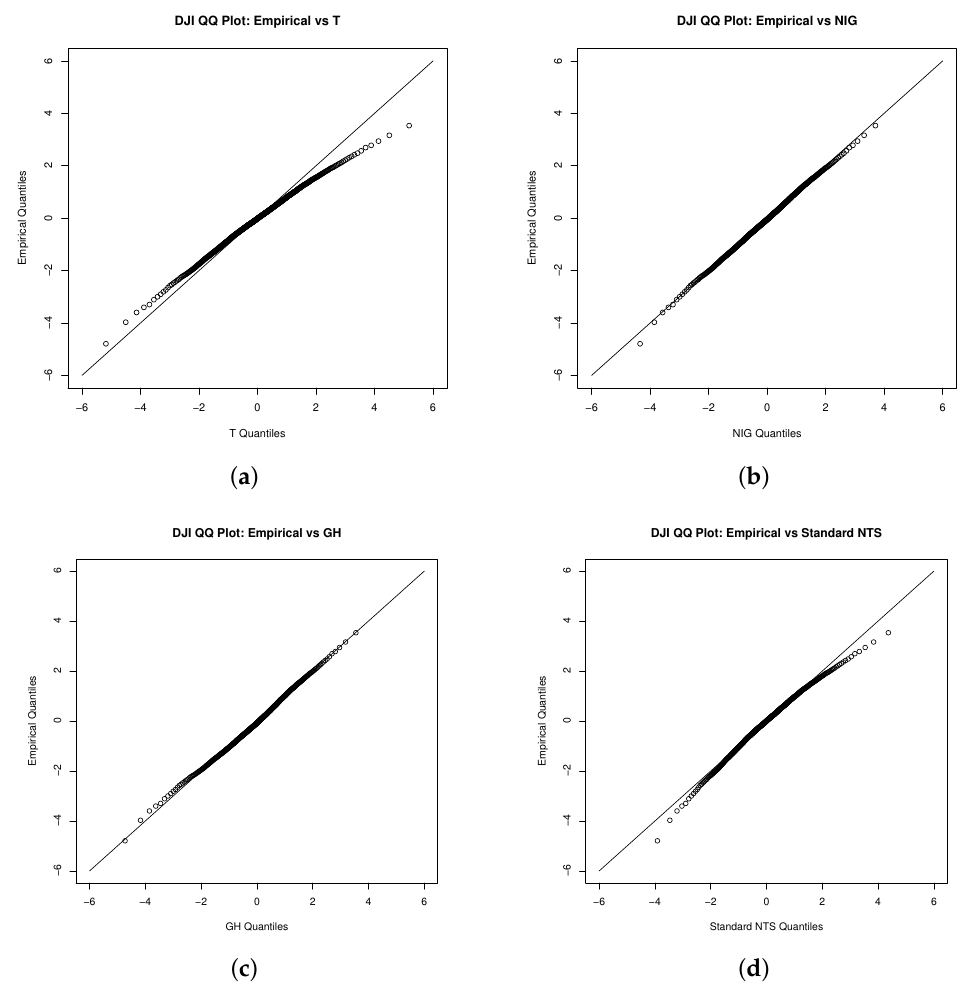
Figure 3. QQ plot for the innovations of Dow Jones index with ( a ) the Student’s t, ( b ) NIG, ( c ) GH, and ( d ) standard NTS